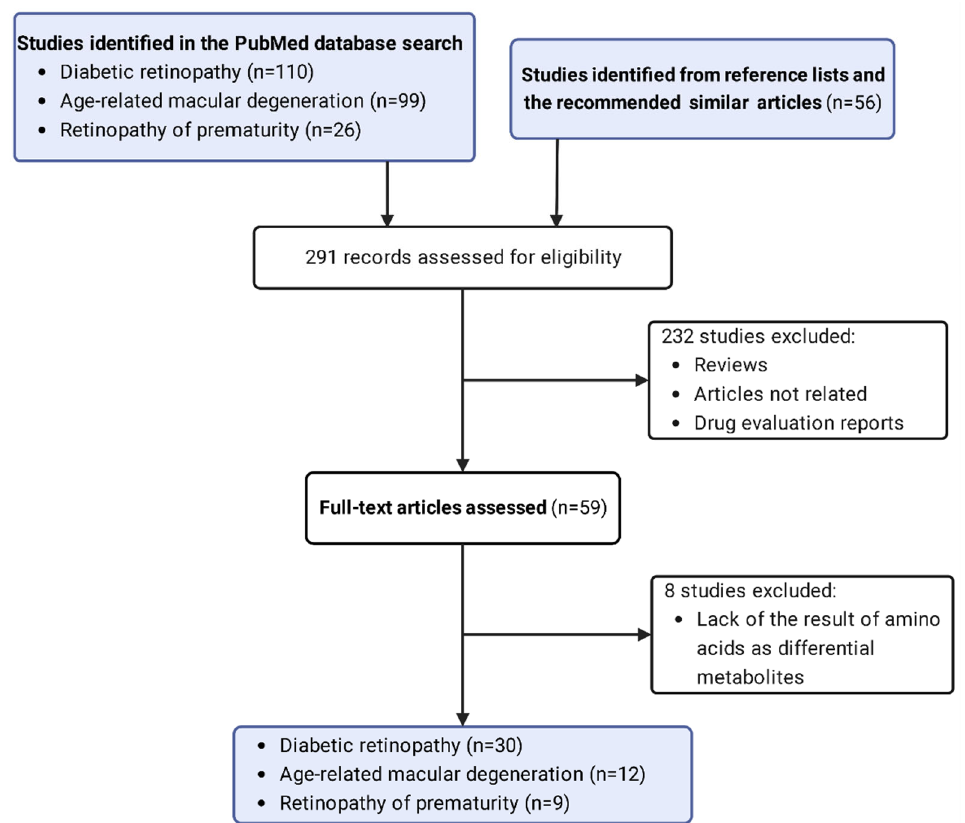
Figure 1. Flow diagram of literature search and study selection for amino acid-based metabolomics of three types of the retinopathy. Studies were searched in the PubMed database with keywords, and 291 records are assessed for eligibility. A total of 232 records remained after exclusion of reviews and articles that are not highly related. Finally, 51 full-text articles with differential amino acids were analyzed in this review including thirty related to diabetic retinopathy, twelve to age-related macular degeneration, and nine to retinopathy of prematurity, respectively.